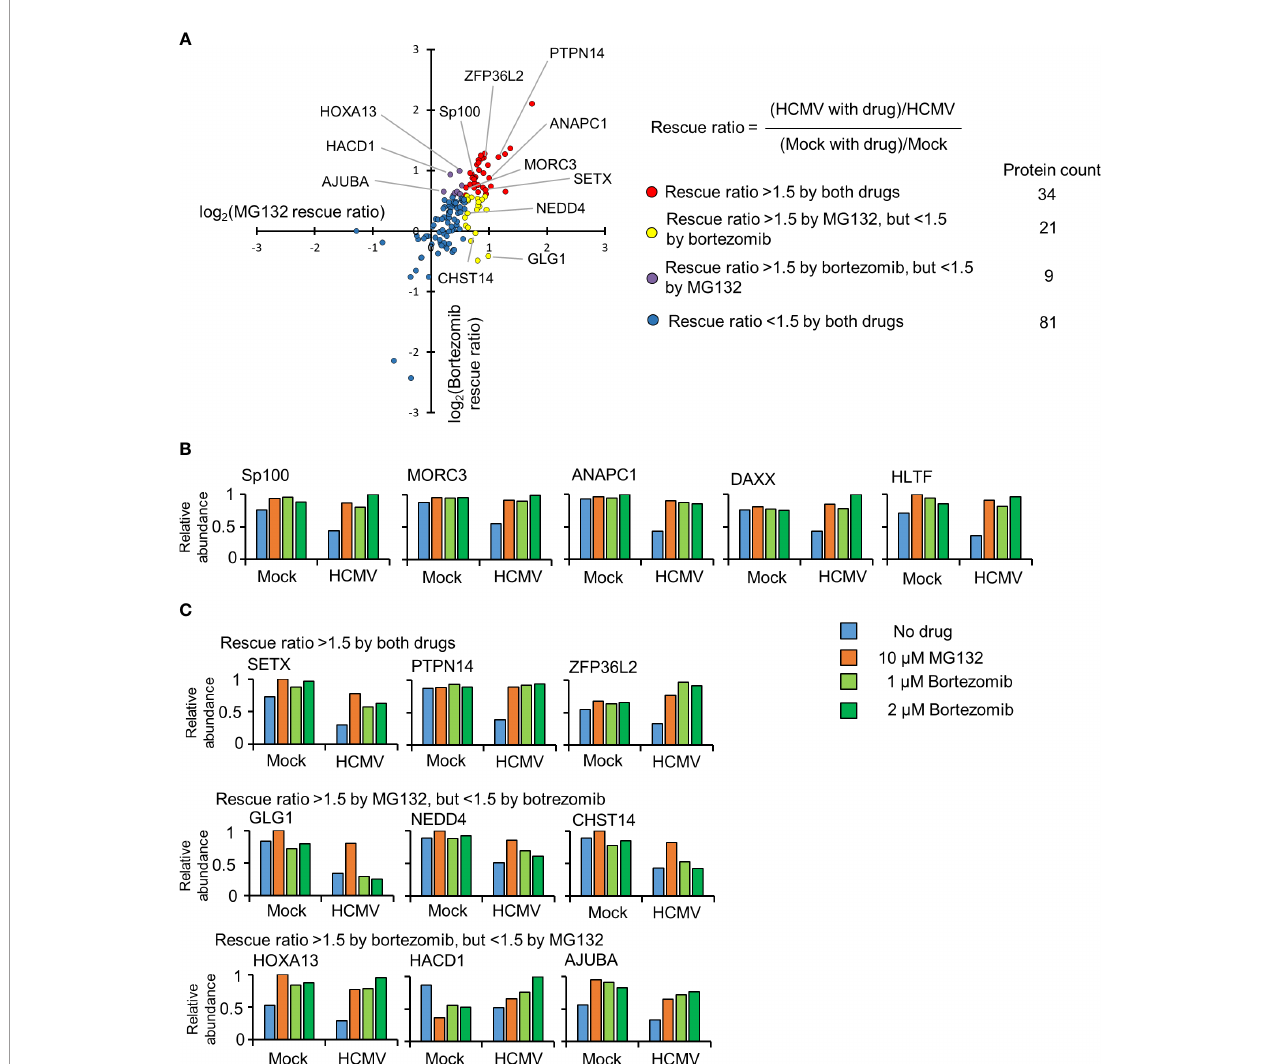
FIGURE 2 | Identi fi cation of proteins targeted for degradation by HCMV using an inhibitor-based proteomic screen. (A) Results of the inhibitor-based screen. All 145 proteins downregulated >1.5 fold are plotted, with down-regulated proteins divided into 4 groups using rescue ratios of >1.5 as cut-offs. The table shows the number of proteins in each group. For rescue ratios, the denominator (mock with drug)/mock was limited to a minimum of 1 to prevent arti fi cial ratio in fl ation. (B) Examples of positive controls from the existing literature that were validated in this screen. (C) Examples of degraded proteins rescued >1.5-fold by both inhibitors (top panels), MG132 but not bortezomib (middle panels), and bortezomib but not MG132 (bottom